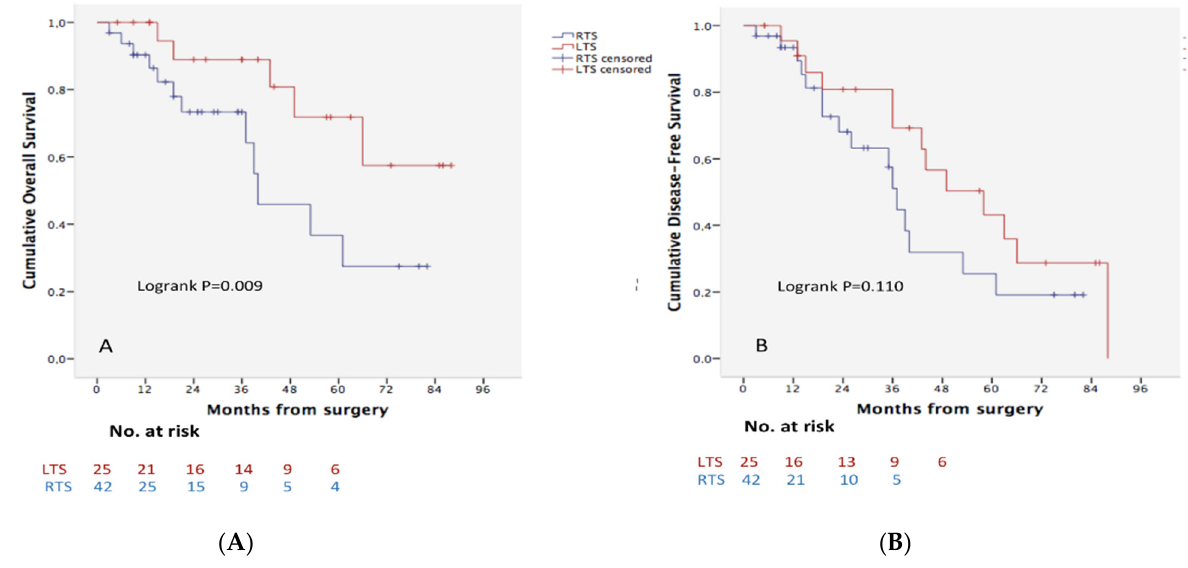
Figure 1. Kaplan–Meier survival analyses. Overall ( A ) and disease-free ( B ) survival curves according to trisectionectomy side. LTS: Left Trisectionectomy; RTS: Right Trisectionectomy. Thirteen clinical and pathological variables were analyzed as potential prognostic factors of survival (Table 4). Multivariable analysis identified LTS (HR: 0.31, 95%CI: 0.13–0.75, p = 0.009), high histological differentiation (HR: 0.11, 95%CI: 0.15–0.83, p = 0.033) and portal microscopic vein invasion (HR: 3.5, 95%CI: 1.3–9.47, p < 0.001) as independent prognostic factors of OS, while radicality of resection (HR: 0.80, 95%CI: 0.30–0.96, p = 0.049) and the absence of lymph node invasion (HR: 0.76, 95%CI: 0.70–0.93, p = 0.037) were independent prognostic factors of DFS. Table 4. Predictors of overall survival and recurrence-free survival.